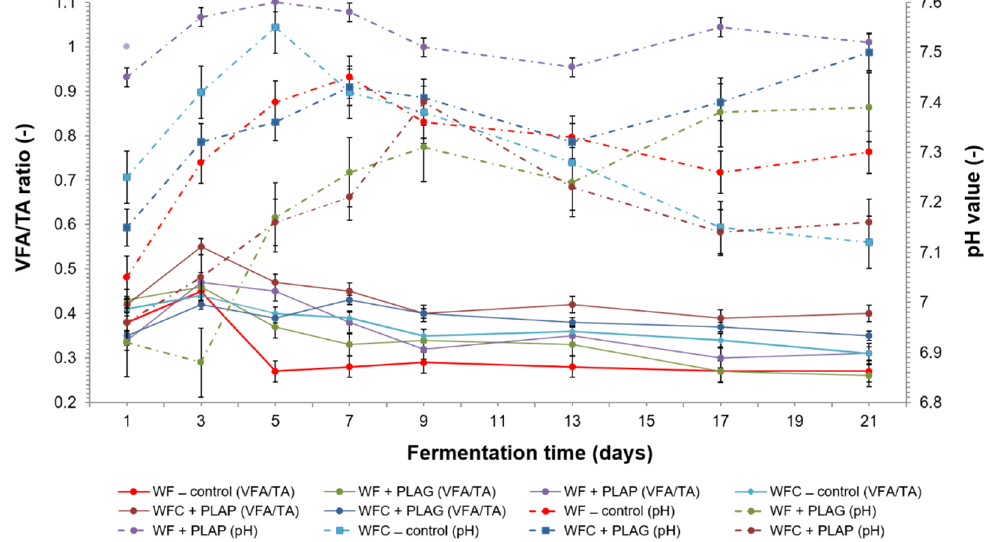
Figure 7. Changes in the pH and VFA/TA ratio during the anaerobic digestion of the